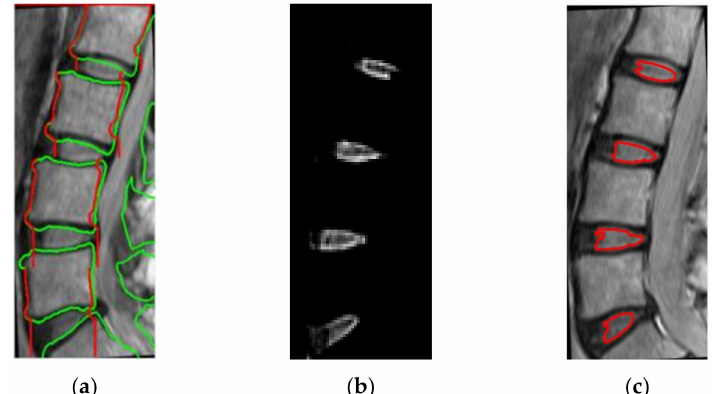
Figure 6. ( a ) The boundary of vertebral stripe, which is marked as red, is derived by the boundaries of the vertebrae, marked as green, ( b ) localization of intervertebral disk (IVD) positions, ( c ) the IVD boundaries extracted after